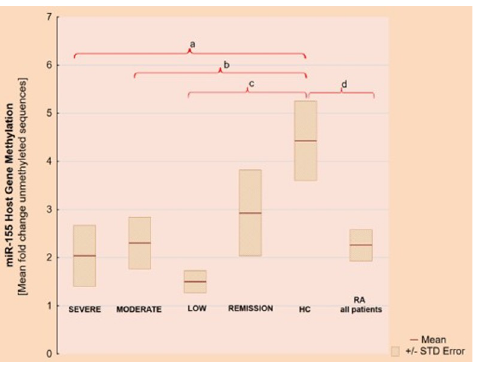
Fig 1. MiR-155 gene methylation level showed as unmethylated sequences–mean fold change. a) p = 0,0008, b) p = 0,0002, c) p = 0,01, d) p = 0,00001.